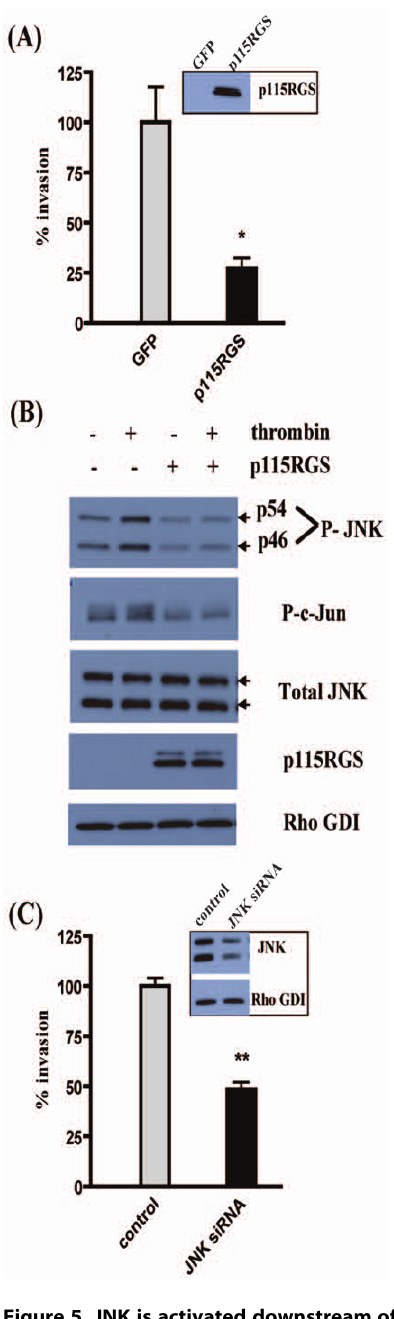
Figure 5. JNK is activated downstream of G12 signaling in 4T1 mammary carcinoma cells and is required for cell invasion. (A) 4T1 cells were infected with adenovirus harboring GFP (control) or the RGS domain of p115RhoGEF (p115RGS) for , 20 h, and then starved for 8 h. Cells were allowed to invade Matrigel for 24 h in the presence of thrombin (1 U/ml), towards 3% FBS. Cells that invaded were stained and counted in four random optical fields for each transwell, with three transwells per condition. Results are shown as percent invasion compared to invasion in the control cells. The inset shows p115RGS expression. Data is presented as mean 6 SE from a single experiment that is representative of three independent experiments. * p , 0.05 as determined by one-way ANOVA, followed by Tukey’s multiple comparison test to obtain p values. (B) 4T1 cells were infected with adenovirus harboring GFP (control) or p115RGS, as indicated, for , 18– 19 h and starved for , 9 h. Cells were then treated with 1 U/ml thrombin for 10 min, as indicated, before lysis in JNK activation buffer. Equal amounts of total protein in the lysates were separated by